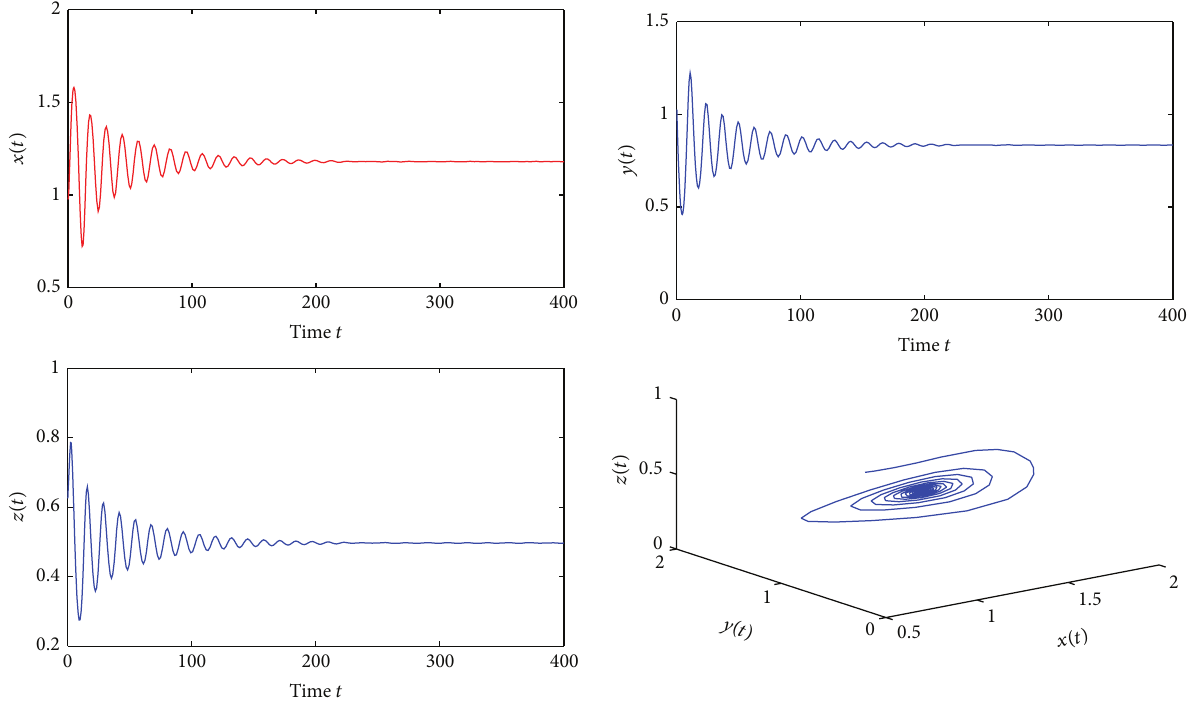
Figure 3: 𝐸 ∗ is asymptotically stable for 𝜏 2 = 1.60 < 𝜏 20 = 1.7990 with initial values 0.975, 1.025, and 0.625.